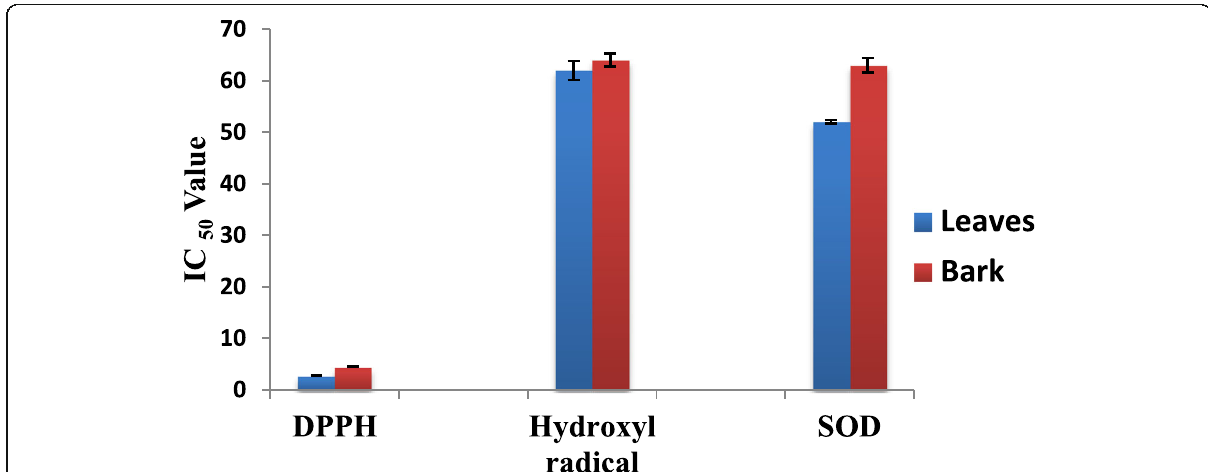
Fig. 12 IC 50 value of the S . palghatense leaves and bark in DPPH radical scavenging assay, hydroxyl radical scavenging activity, and superoxide radical scavenging